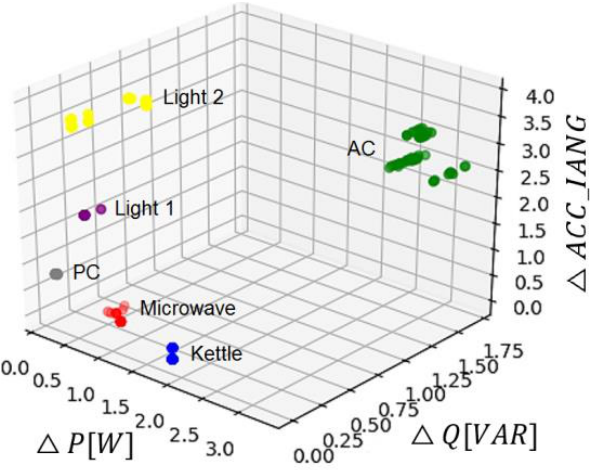
Figure 9. Three-dimensional results: AC (green), Light 1 (purple), Light 2 (yellow), Kettle (blue), Microwave (red), Computer (gray). Delta P is active power difference, Delta Q is reactive power difference, Delta ACC_ANG is the scaled phasor angle difference.